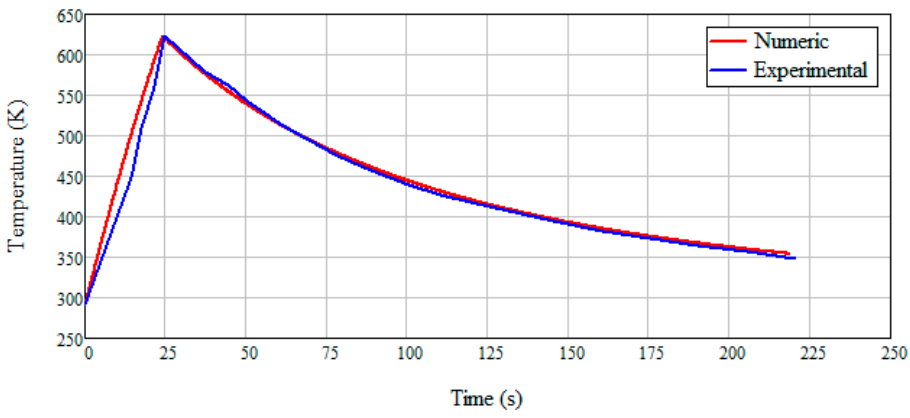
Figure 7. Numerical and experimental temperature variations over time on the right side of the heat shield.